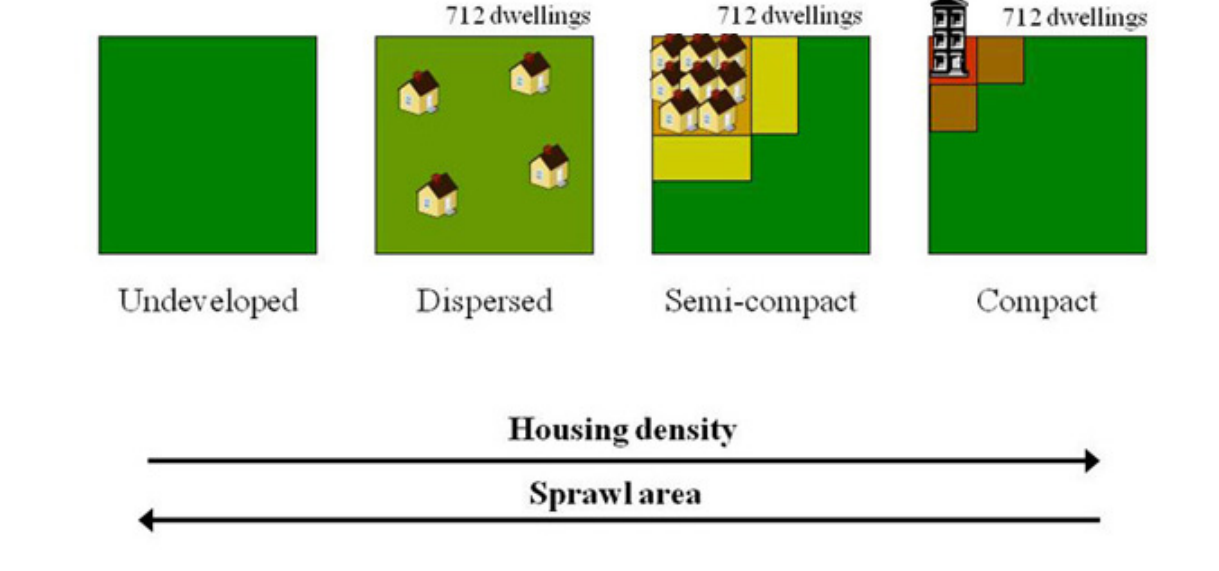
Fig. 3 . Hypothetical development scenarios representing a gradient of increasing housing density and decreasing sprawl area. For a given forested area (the Undeveloped scenario), the same number of dwellings is depicted at three housing densities (Exurban, Suburban, and Urban), resulting in Dispersed, Semi-compact, and Compact development patterns, respectively. Yellow and brown areas represent forest habitat adjacent to development typical of Suburban Neighbor and Urban Neighbor sites, respectively. Drawings, including proportions of each cover type in each scenario, are not to scale. For example, the developed portion of the Semi-compact scenario was 6.18% of the total area of the scenario. Scenarios were 22.96 km 2